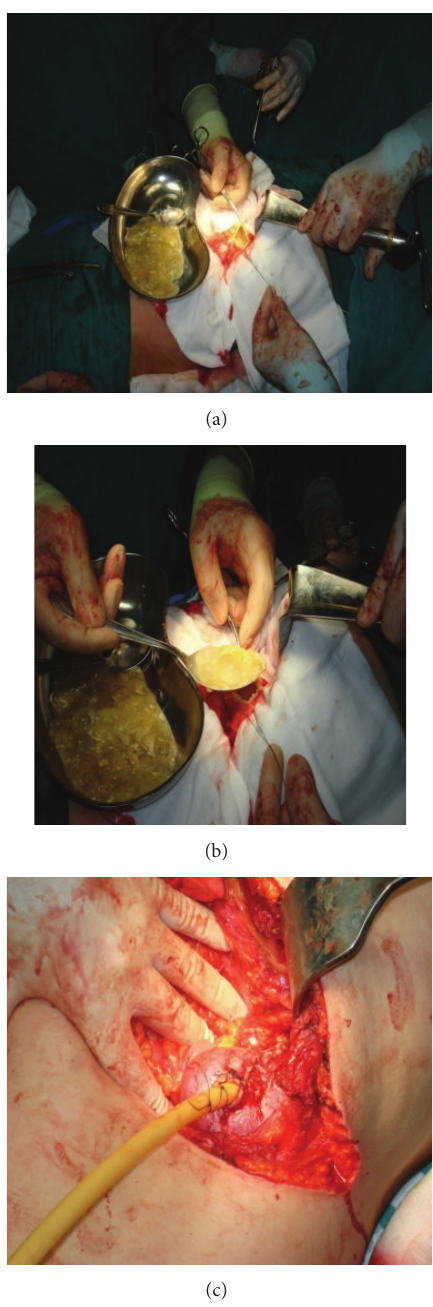
Figure 3: Intraoperative removal of the cyst’s content and drain